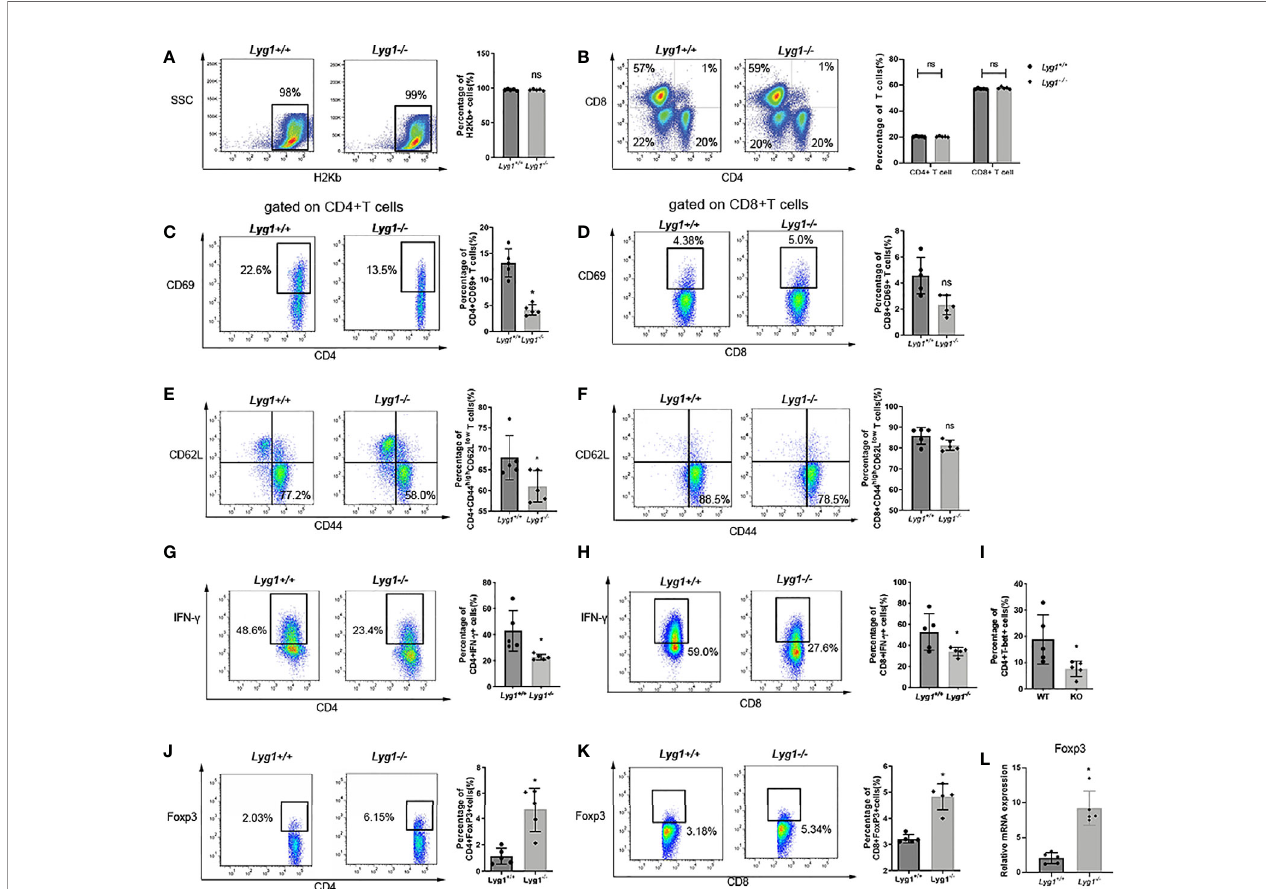
FIGURE 3 | LYG1 de fi ciency reduced allogeneic T cells function in spleens. Splenocytes of recipient mice were isolated on day 7 after transplantation and analyzed by fl ow cytometry and qPCR. (A) The percentages of H2Kb+ cells in living splenocytes. (B) The percentages of CD4+ T and CD8+ T cells in H2Kb+ splenocytes. (C, D) The percentages of CD69 expression in CD4+ T cells and CD8+ T cells. (E, F) The expression of effector (CD44hiCD62Llo) phenotype gated on CD4+ T and CD8+ T cells. (G, H) The percentages of IFN-g expression in CD4+ T cells and CD8+ T cells. (I) The percentages of T-bet expression in CD4+ T cells. (J, K) The percentages of Treg in CD4+ T cells and CD8+ T cells. The percentages of Figure 3 (C – K) were all gated on H2Kb+CD4+ cells or H2Kb+CD8+ cells. (L) Foxp3 expression of splenocytes were examined by qPCR. Independent experiment was performed 3 times. The results in the repeats were similar. n = 5 per group. Representative plots are shown and statistical results are expressed as the mean ± SD, *p < 0.05 compared with Lyg1+/+ group. ns, no signi fi